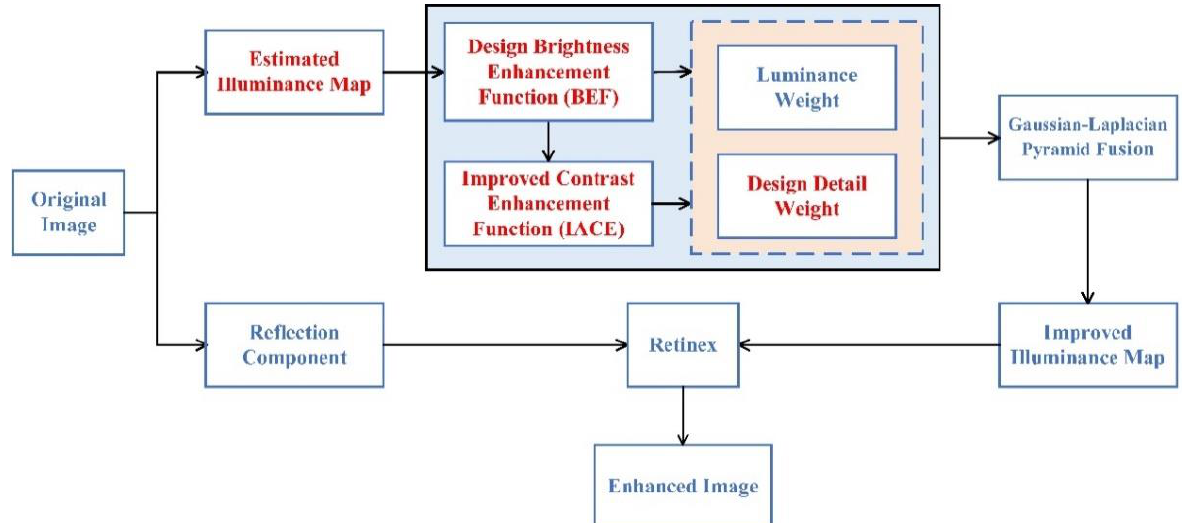
Figure 1. The general process of the proposed model.